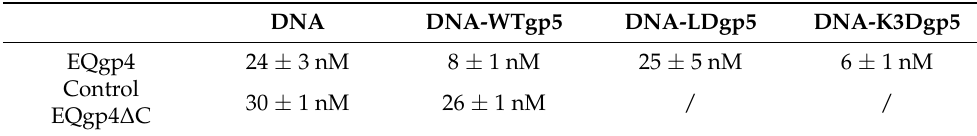
Table 2. K d of the DNA-gp5 variants complexed with EQgp4 and EQgp4 ∆